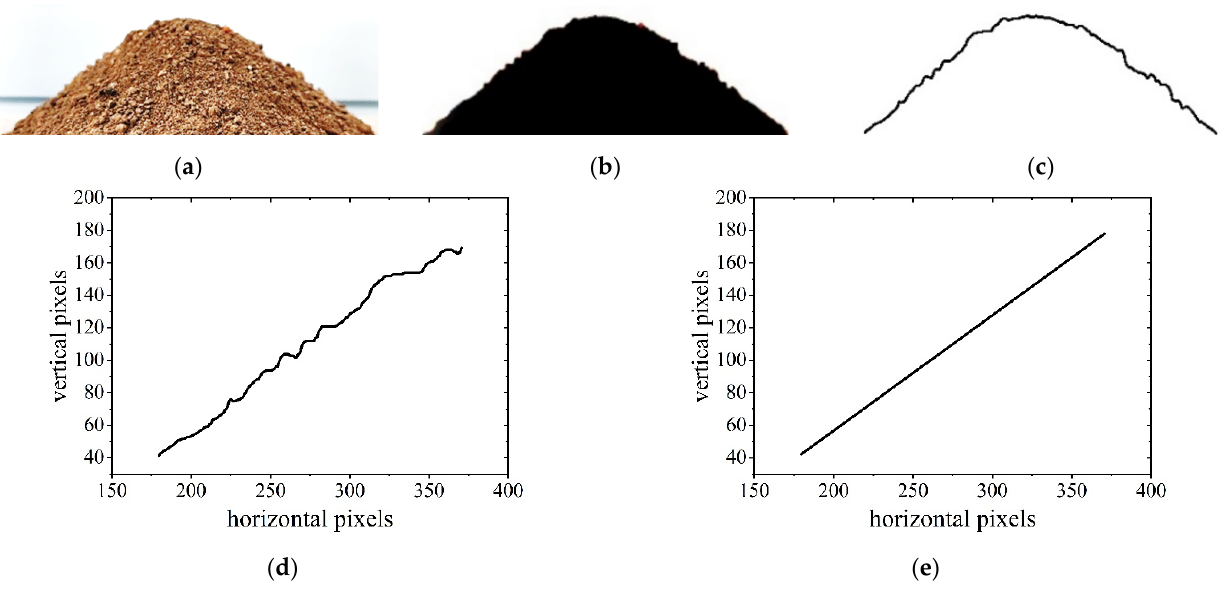
Figure 3. Rest angle measurement steps: ( a ) original image; ( b ) Photoshop processed image; ( c ) ex- traction of boundaries; ( d ) left half taken to draw a scatter plot; ( e ) curve fitting.